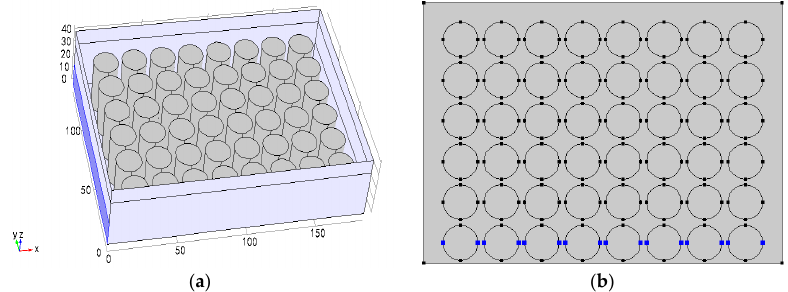
Figure 1. ( a ) A quarter of the schematic view for a planar battery arrangement; and ( b ) distribution of monitoring points.